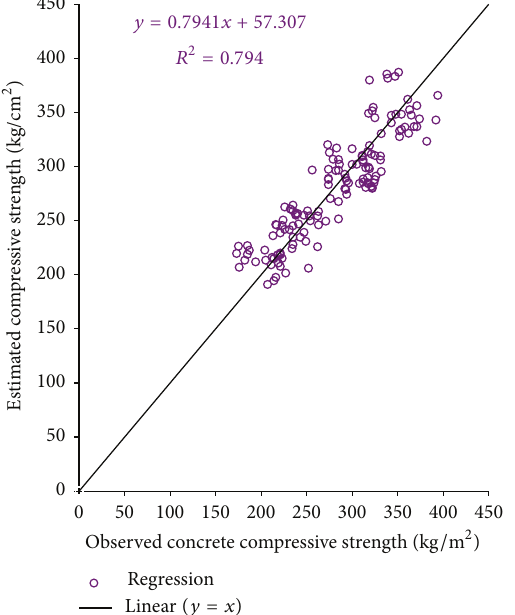
Figure6:Comparisonofobservedcompressivestrengthofconcrete and estimated compressive strength by EANN (MLP) and MLR regression model.